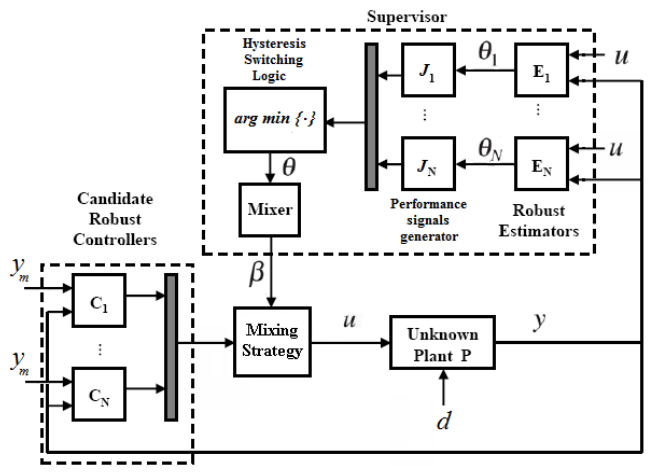
Figure 1. Multi-AMC